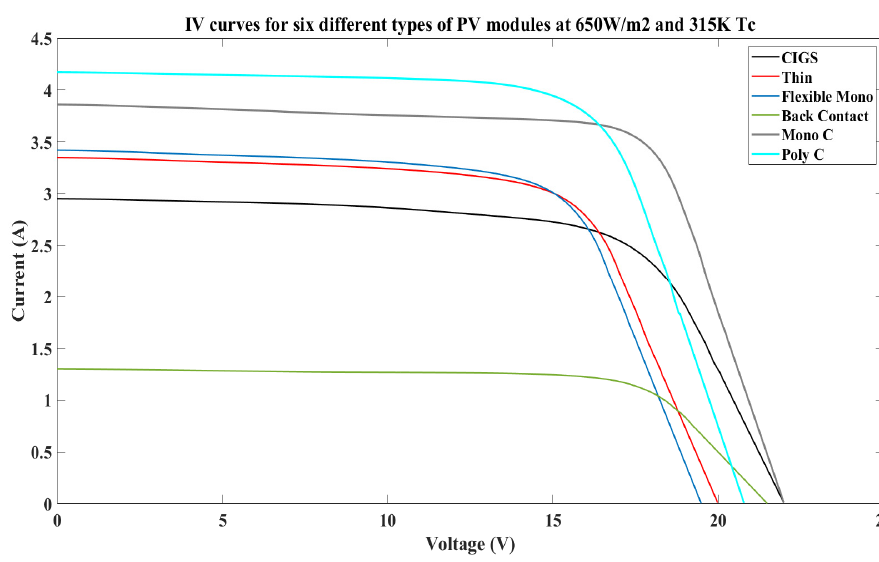
Figure 13. Predicted IV curves for the six PV modules at 650 W/m 2 and 315 K T c .